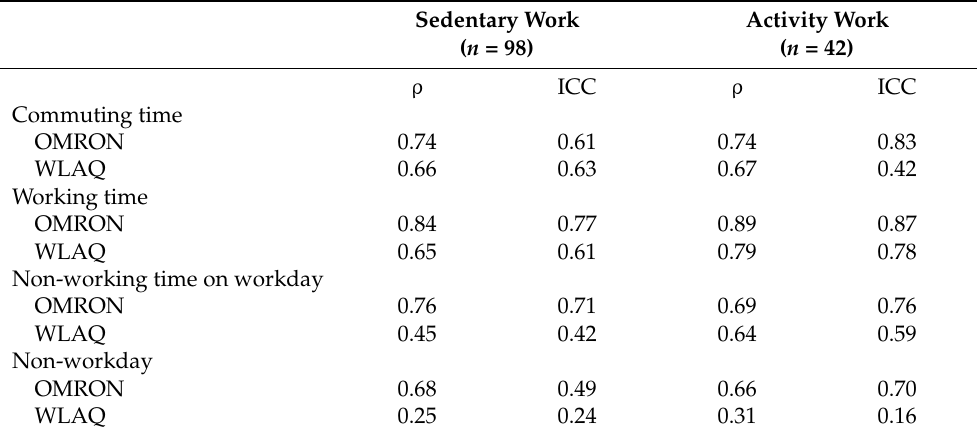
Table 4. Criterion validity of values measured by OMRON and WLAQ compared with acticPAL by the